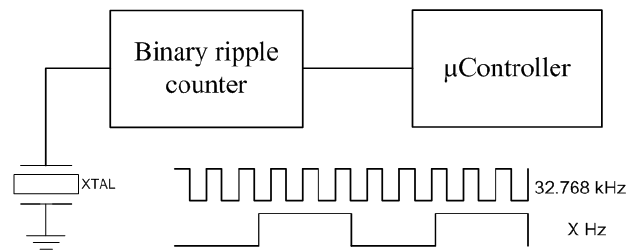
Figure 2. Introduction to a binary ripple counter that permits the microcontroller to enter sleep